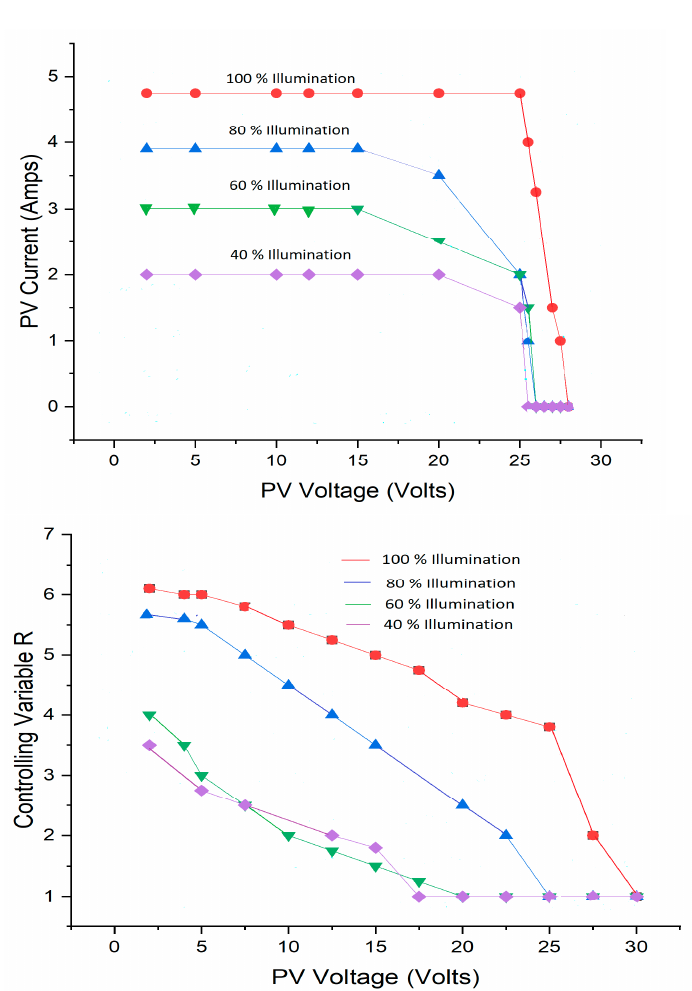
Figure 2. V-I and V-R characteristics for different illuminations.